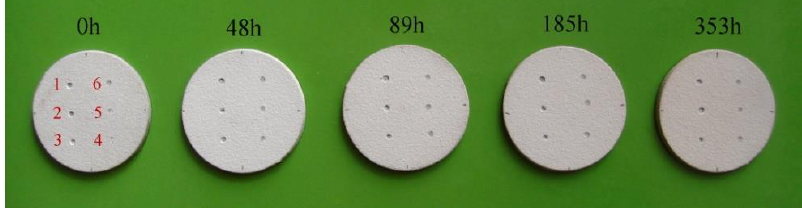
Figure 1. View of the samples after impact testing.